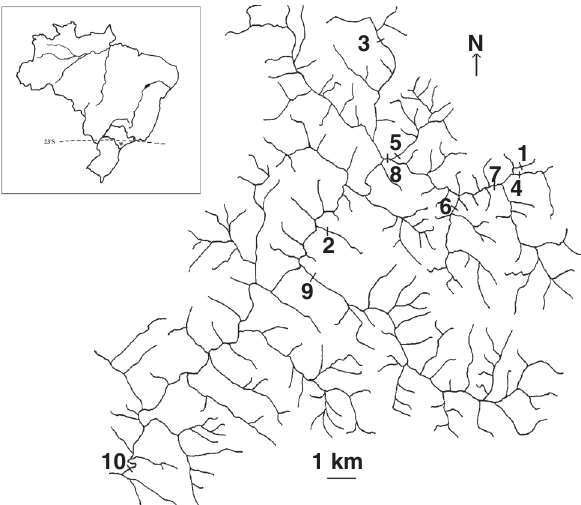
Figure 1. Location of the Rio do Carmo catchment in Brazil and the location of the 10 stream sites